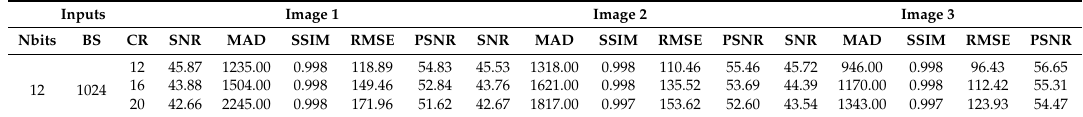
Table 3. Compression Results. Achieved SNR, MAD, SSIM, RMSE and PSNR for Image 1, Image 2 and Image 3.